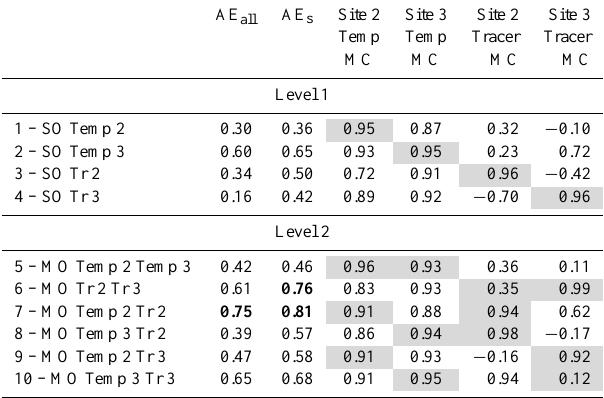
Table 3. Results for single objective (SO, Level 1) and multi- objective (MO, Level 2) calibration tests. Including HTS data gives the AE all result shown in Column 1, excluding HTS and using only main channel (MC) and STS data resulted in AE s shown in Col- umn 2. Following the AE all and AE s results are the E results for each test in the simulation matrix. E and AE s were used to de- termine the best models using parameter sets that meet both local ( E > 0.8) and global (AE S > 0.7, bolded) criteria. AE all was in- cluded for comparison to Level 3 and 4 calibrations. Shown in grey shading are the Site 2 and Site 3 locations in the main channel used for a calibration objective; unshaded boxes in Columns 3–6 are lo- cations where data were withheld during the calibration.